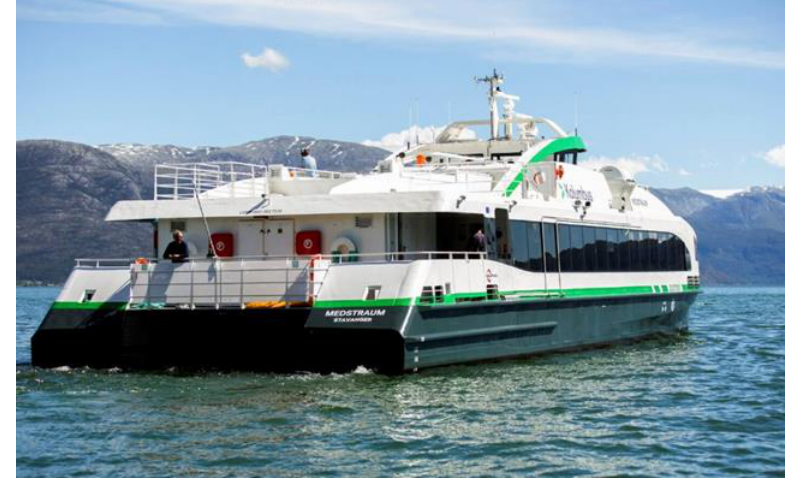
Figure 9. High-speed craft MS Medstraum [61].